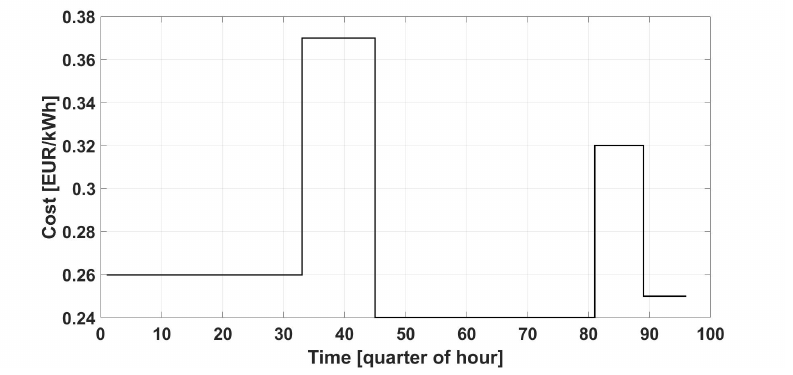
Figure 3. Energy